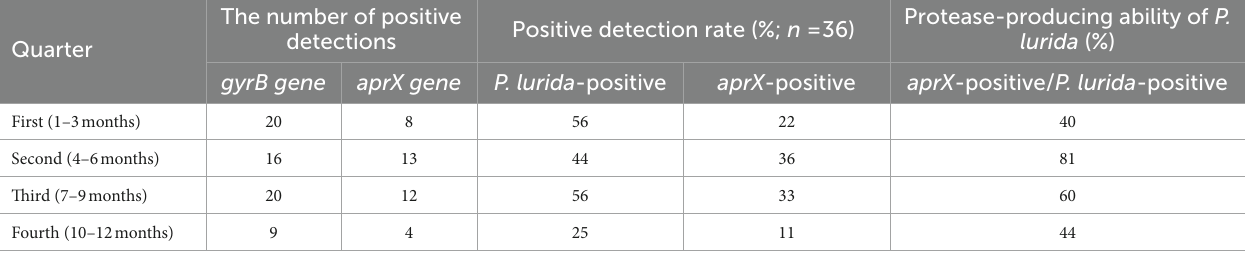
n = 36: 36 samples were tested each quarter. TABLE 4 RealAmp detection results of Pseudomonas lurida in raw milk samples collected from different pastures.